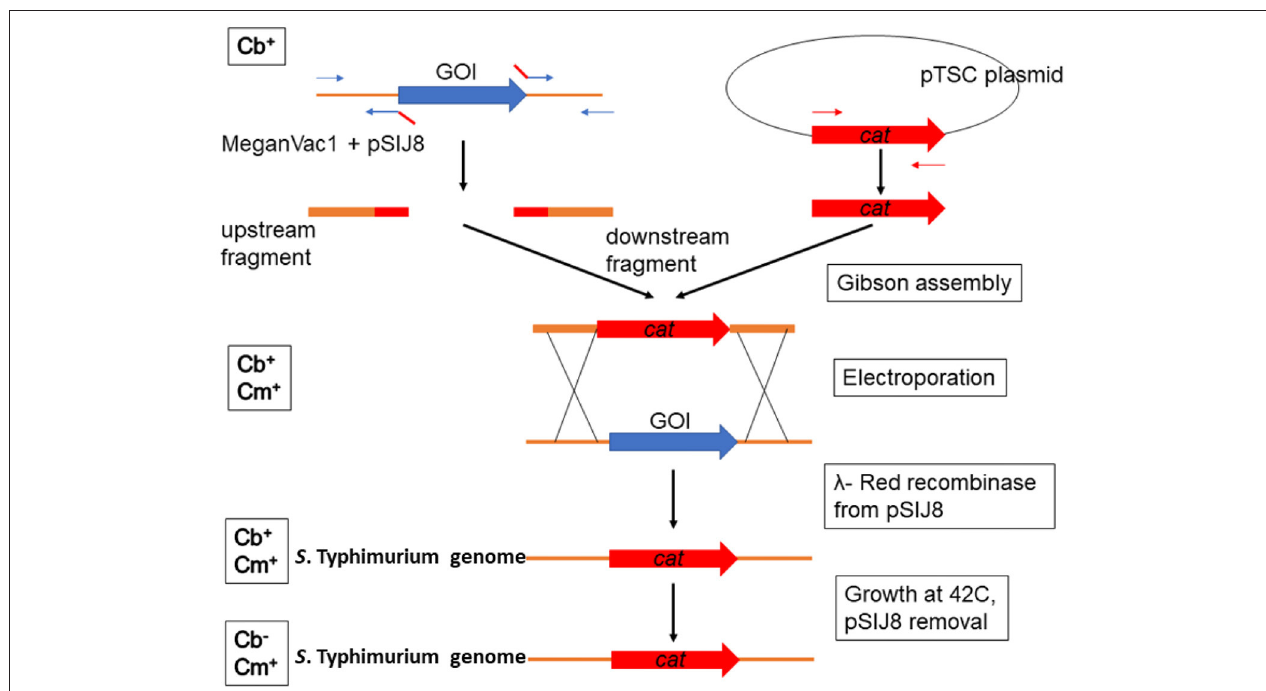
FIGURE 2 | Schematic diagram showing the construction of S. Typhimurium UK1 1 crp - cya derivatives. λ -red recombinase mediated homologous recombination was used to replace the gene of interest (GOI) with a chloramphenicol cassette. Abbreviations in the left side boxes suggest sensitivity toward carbenicillin (Cb) and chloramphenicol